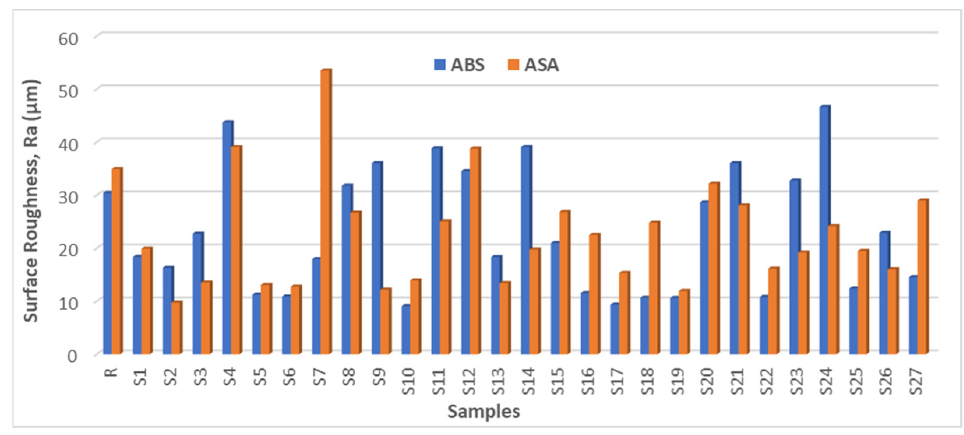
Figure 2. Surface roughness